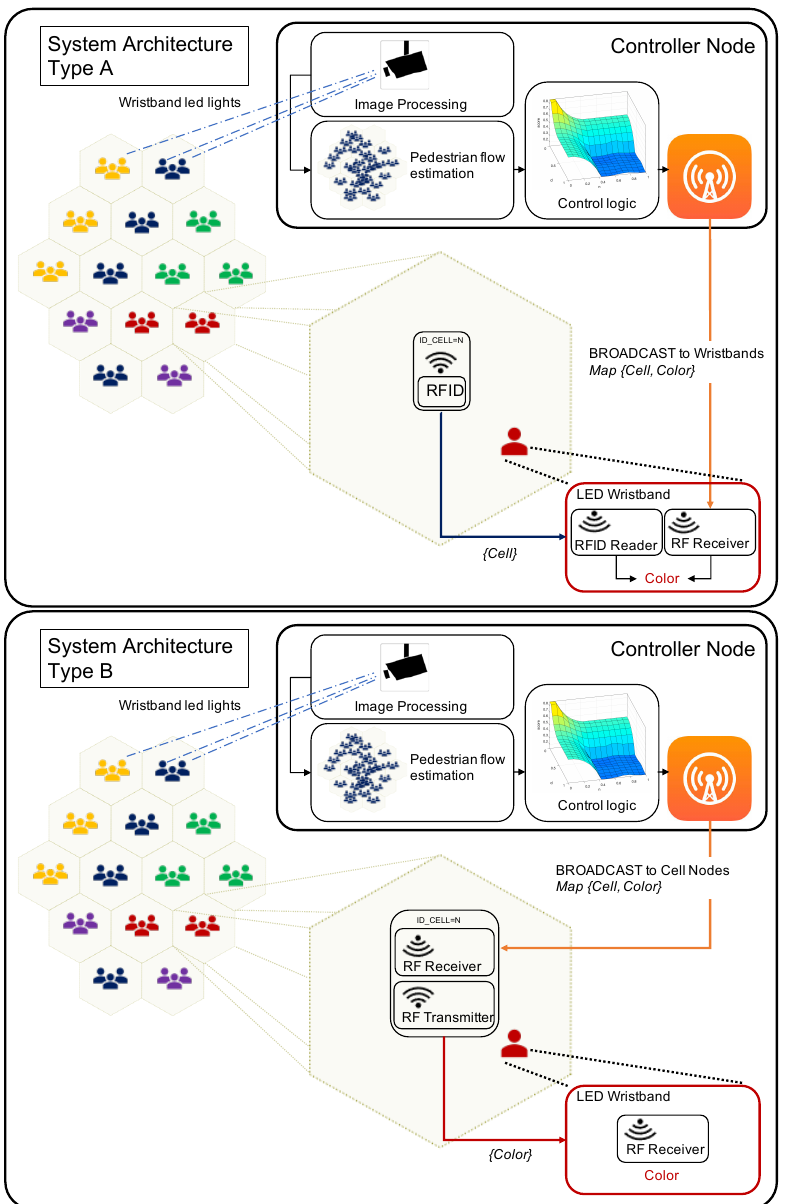
Figure 3. CellEVAC System Architecture: Types A and